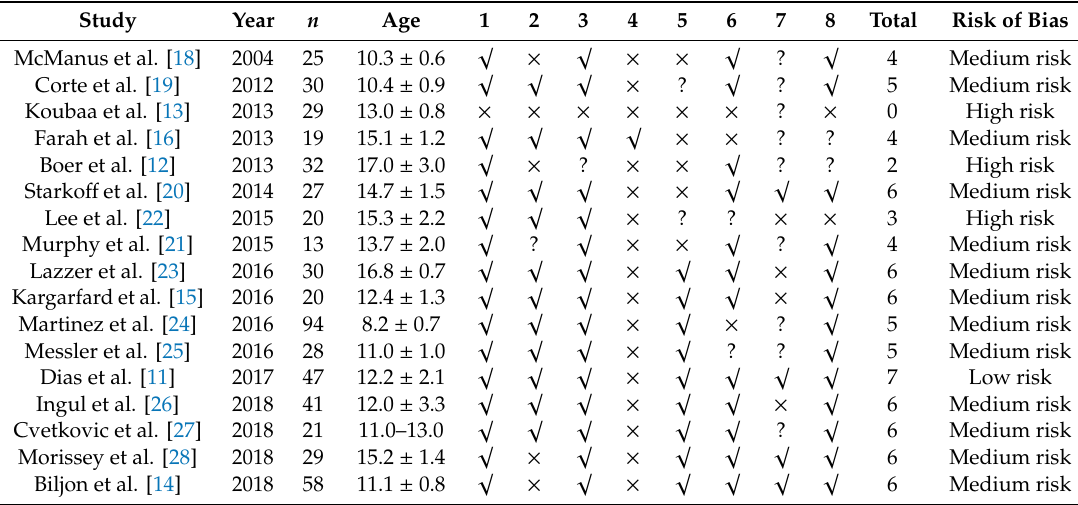
Table 2. Quality assessment / risk of bias of 18 included